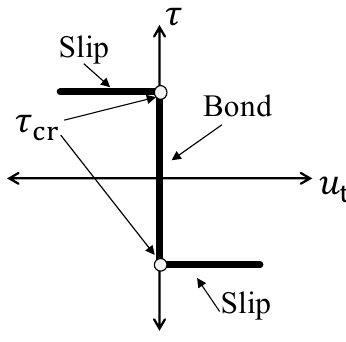
Figure 6. Coulomb’s friction law.